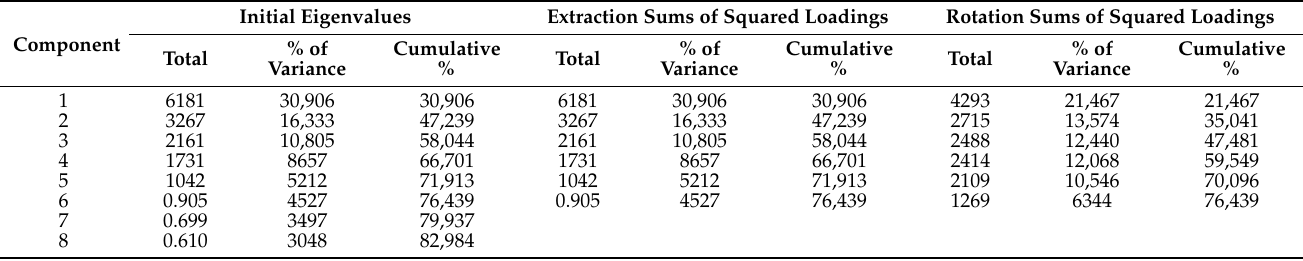
Table 3. Total variance explained by the model 1